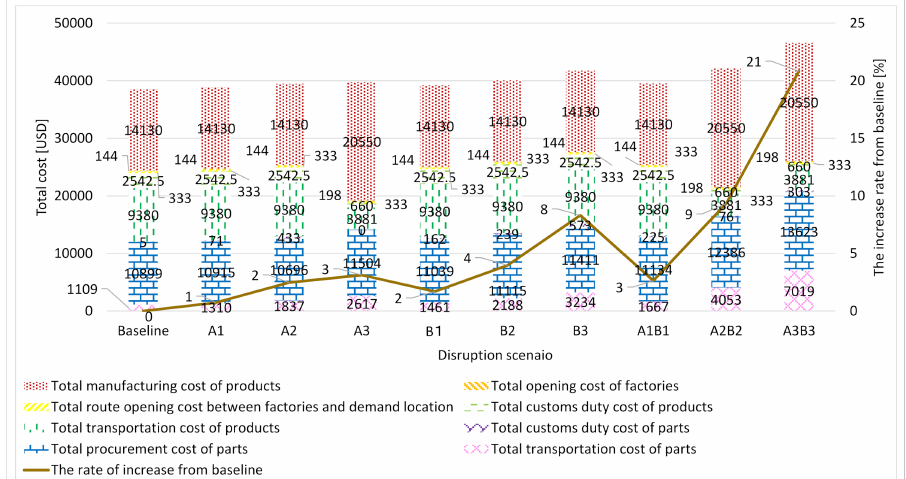
Figure 6. Results of the total cost and their breakdown across scenarios.